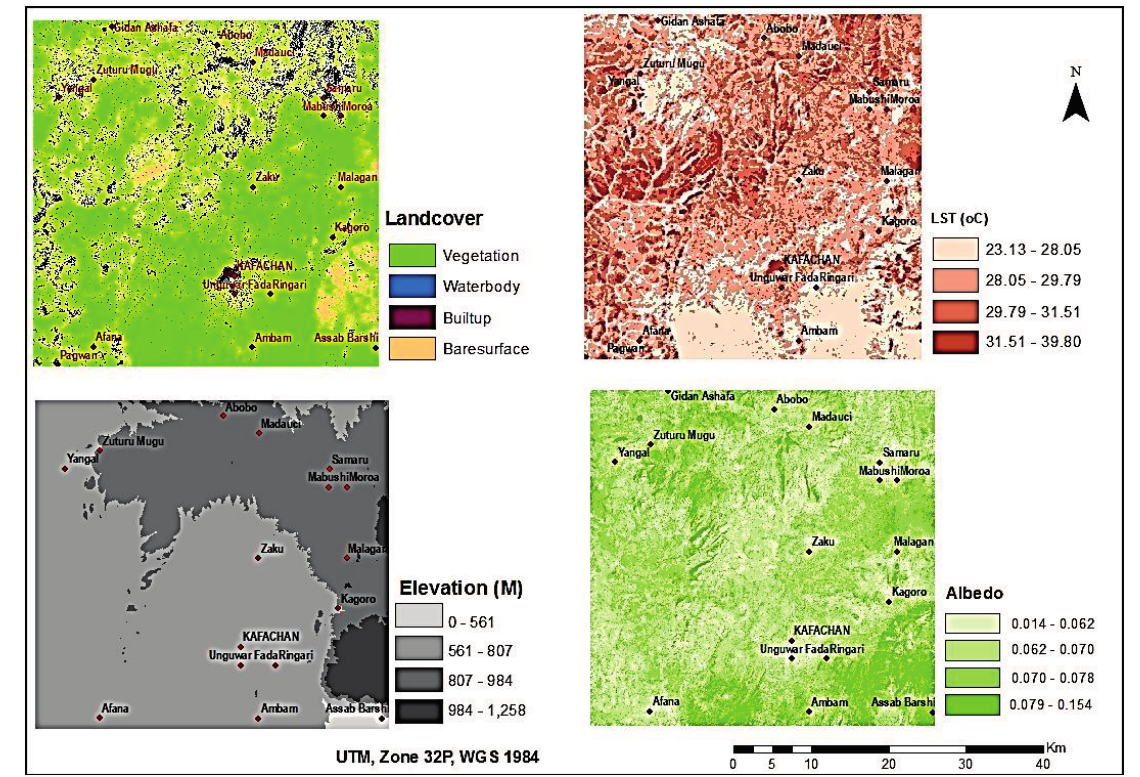
Figure 8. Landcover, LST, topography and albedo in Kafachan in 1986.